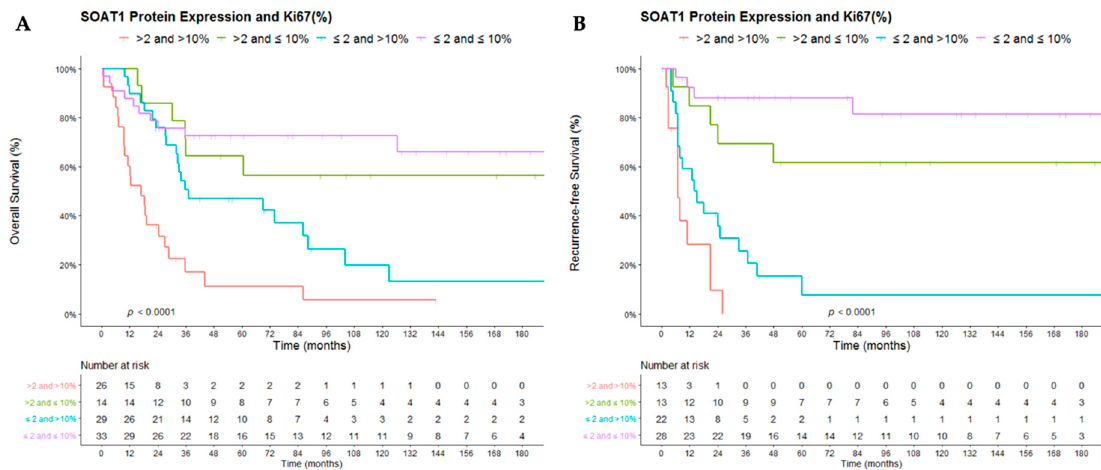
Figure 4. Impact of Ki67 index and SOAT1 protein expression on ( A ) overall survival and ( B ) recurrence-free survival in adult patients with ACC. For recurrence-free survival analysis, only patients with complete resection (status of resection R0) have been analyzed.